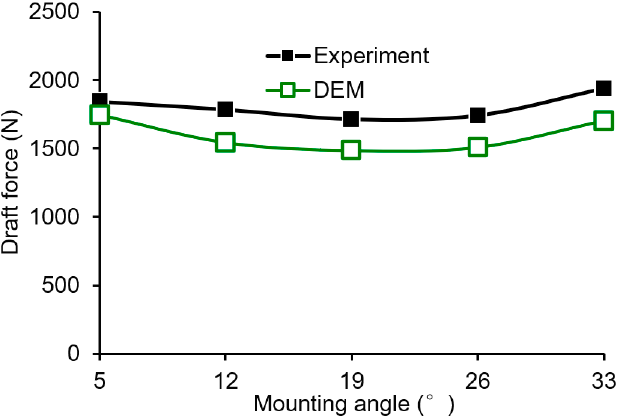
Figure 10. Draft forces of the bending subsoiling tool as affected by mounting